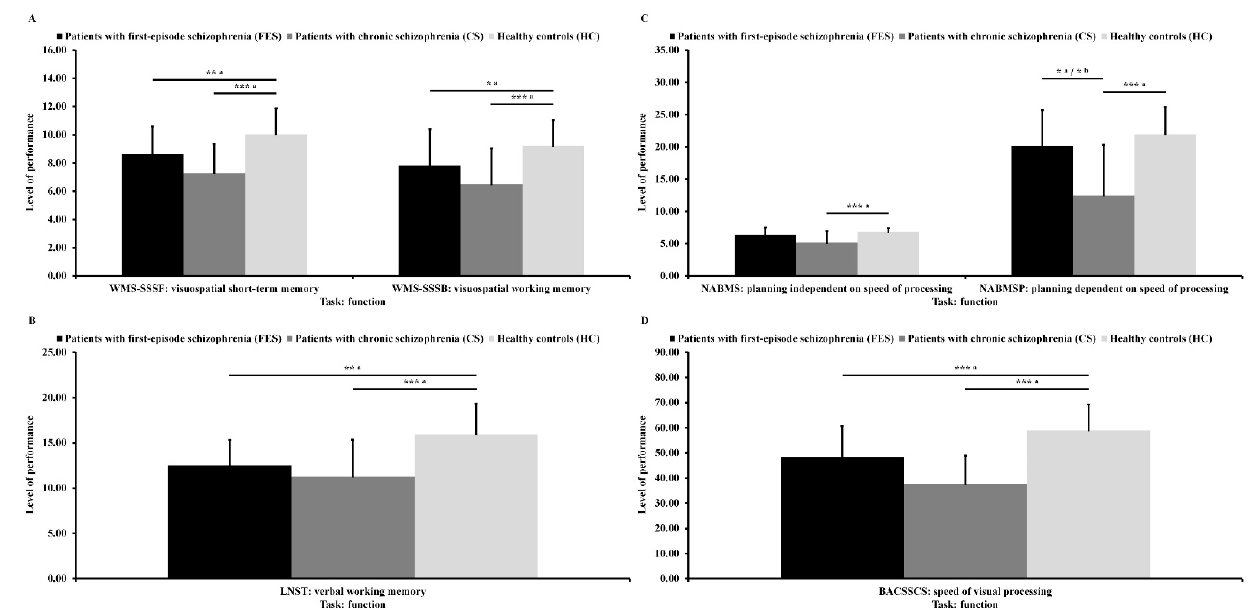
Figure 3. Performance of visuospatial memory ( A ), verbal working memory ( B ), planning ability ( C ), and speed of visual processing ( D ) for all participants. a Significant difference after co-varying age. b Significant difference after co-varying age, duration of illness, exacerbation, and positive symptoms. * p < 0.05. ** p < 0.01. *** p < 0.001.